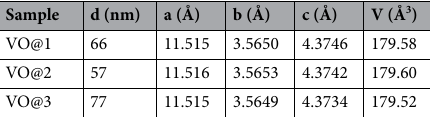
Table 1. Crystallite sizes, lattice parameters of V 2 O 5